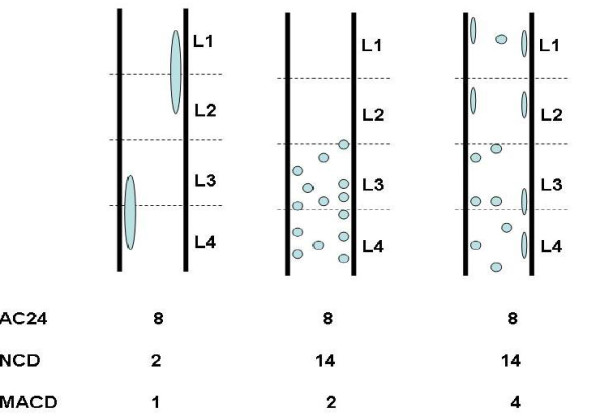
Examples of scores for the AC24 and MACD index according to the size and distribution of the aortic calcifications. Only MACD is influenced by both size and distribution of the lesions.